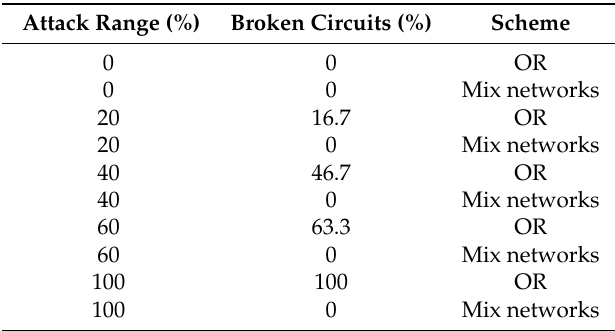
Table 6. Attack range with broken-circuit